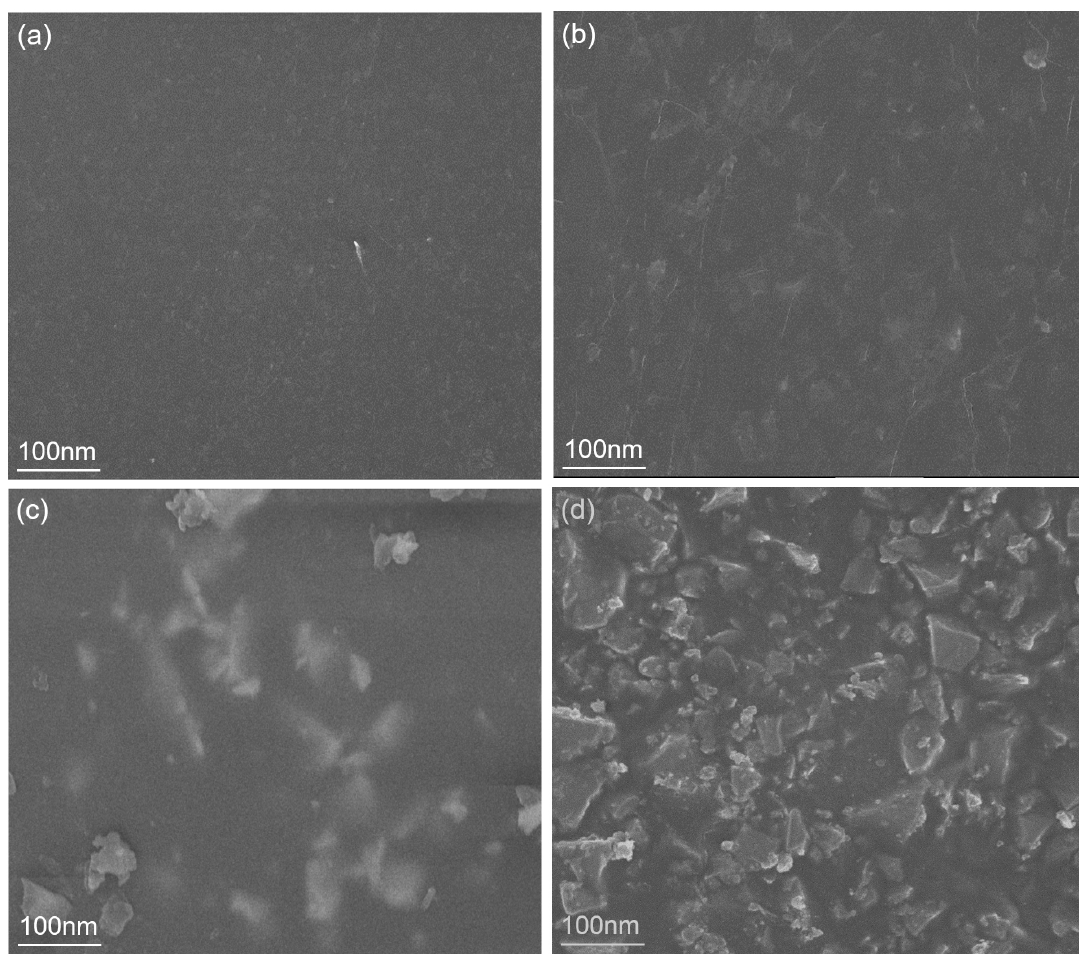
Figure 5: SEM images of nano-silica modified phenolic resin film of (a) 0%, (b) 2%, (c) 4% and (d) 6%